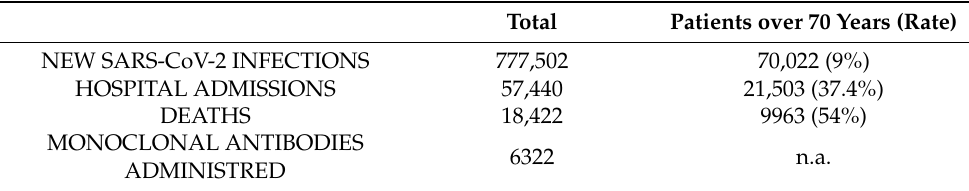
Table 1. Data obtained in the period of